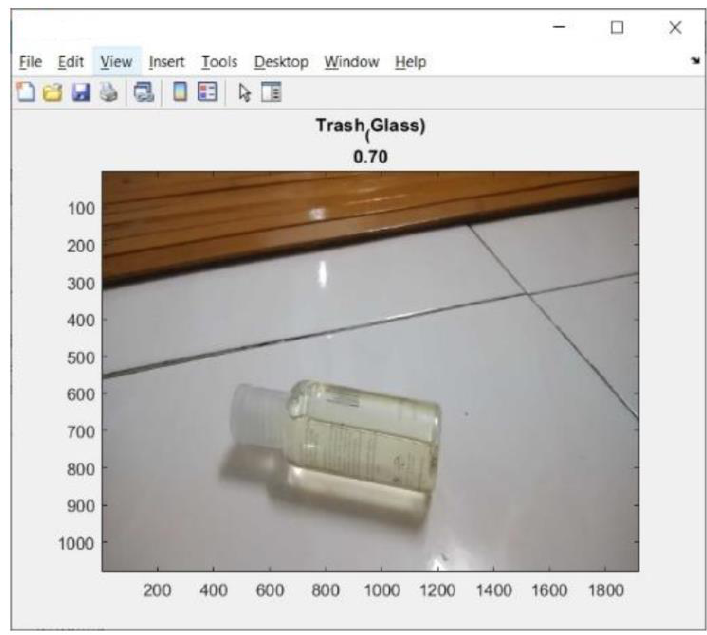
Figure 22. Result of the error trash identification. Table 6. The Accuracy of 11 Types of Trash Using a Real-Time Camera with Pre-Trained AlexNet.